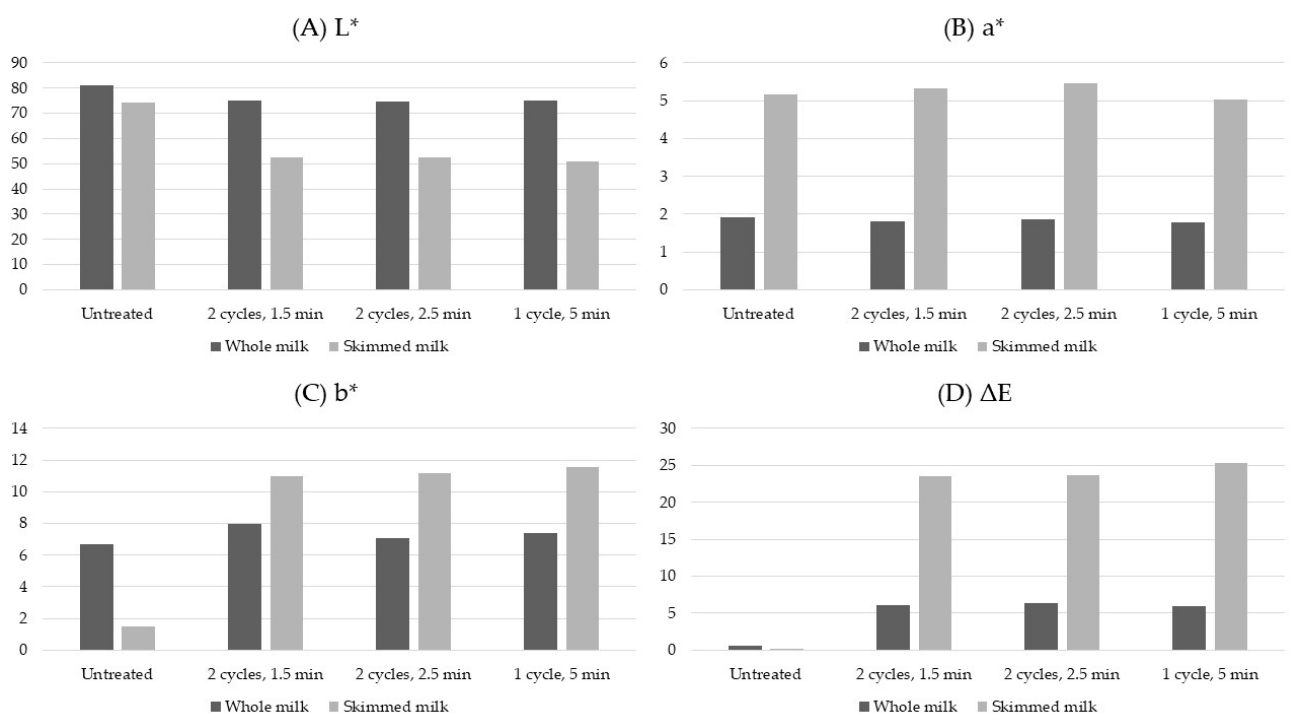
Figure 7. L* ( A ), a* ( B ), b* ( C ) and ∆ E ( D ) color parameters of whole and skimmed milk treated at 600 MPa for different treatment times and cycles